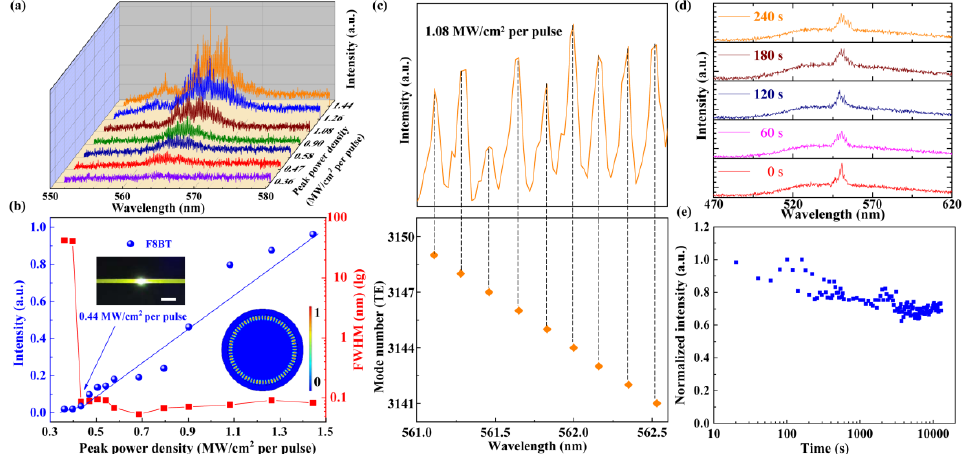
Figure 2. ( a ) The emission spectrum of the diode pumped tunable polymer WMG laser. ( b ) The intensity and the FWHM of the output emission at a different current, demonstrating the lasing threshold is 0.43 MW/cm 2 per pulse marked by an arrow. Top left inset is the optical image of microfluidic channel. Scale bar is 800 µ m. Bottom right illustration is the distribution of electric field intensity in transverse cross-section. ( c ) The lasing spectra from the quartz capillary, m λ m = π n eff D, where m is mode number, λ m is the wavelength. The corresponding mode number is from 3141 to 3149. ( d ) The evolution of emission spectrum from 0 s to 240 s. ( e ) The stability of laser diode pumped polymer WGM laser.